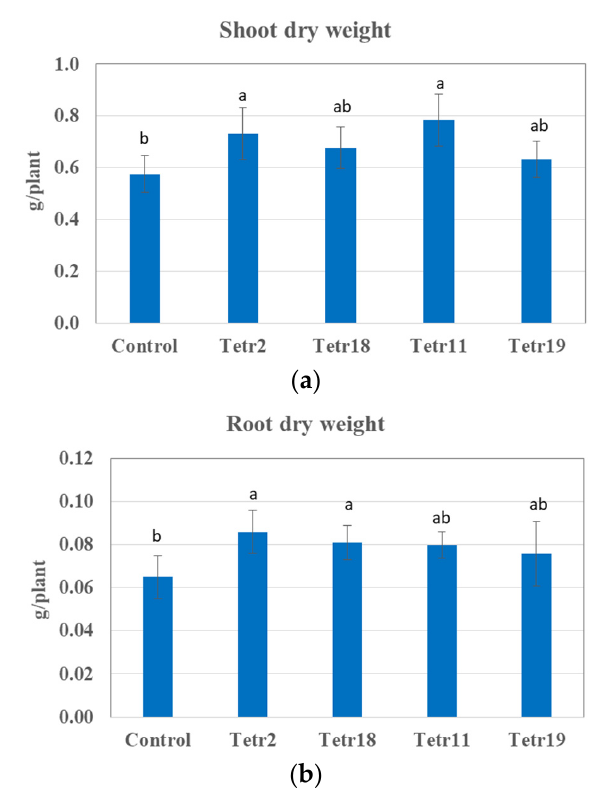
Figure 2. The effect of endophytic bacteria Stenotrophomonas maltophilia Tetr 2, Pseudomonas moraviensis Tetr 18, Bacillus amyloliquefaciens Tetr 11, and Curtobacterium plantarum Tetr 19 on shoot ( a ) and root dry weight ( b ) of Tetragonia tetragonioides (Pall.) Kuntze. The plants were grown under 200 mM NaCl conditions in a greenhouse for 30 days at 24 °C/16 °C (day/night). Column means with different letters are significantly different based on Tukey’s HSD test at p < 0.05.